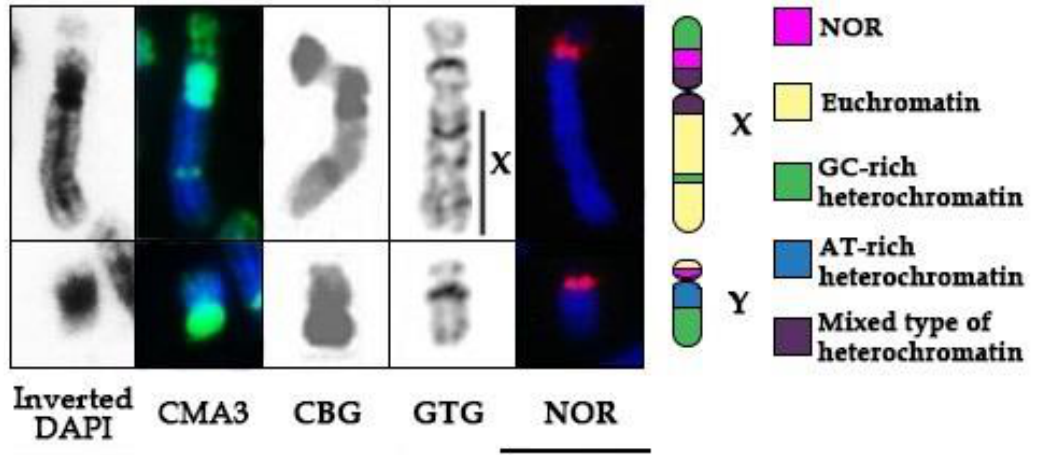
Figure 2. Differential staining of sex chromosomes (X, Y) of Javan mouse-deer: Inverted DAPI (AT-rich heterochromatin) CDAG-staining; CMA3 (GC-rich heterochromatin) CDAG-staining; CBG (CBG–C-bands by Barium hydroxide using Giemsa) [33]; GTG (G-bands by Trypsin using Giemsa) [35]; DAPI-staining and FISH localization of 18S, 5,8S and 28S rDNA probe. Scale bar = 10 µm.